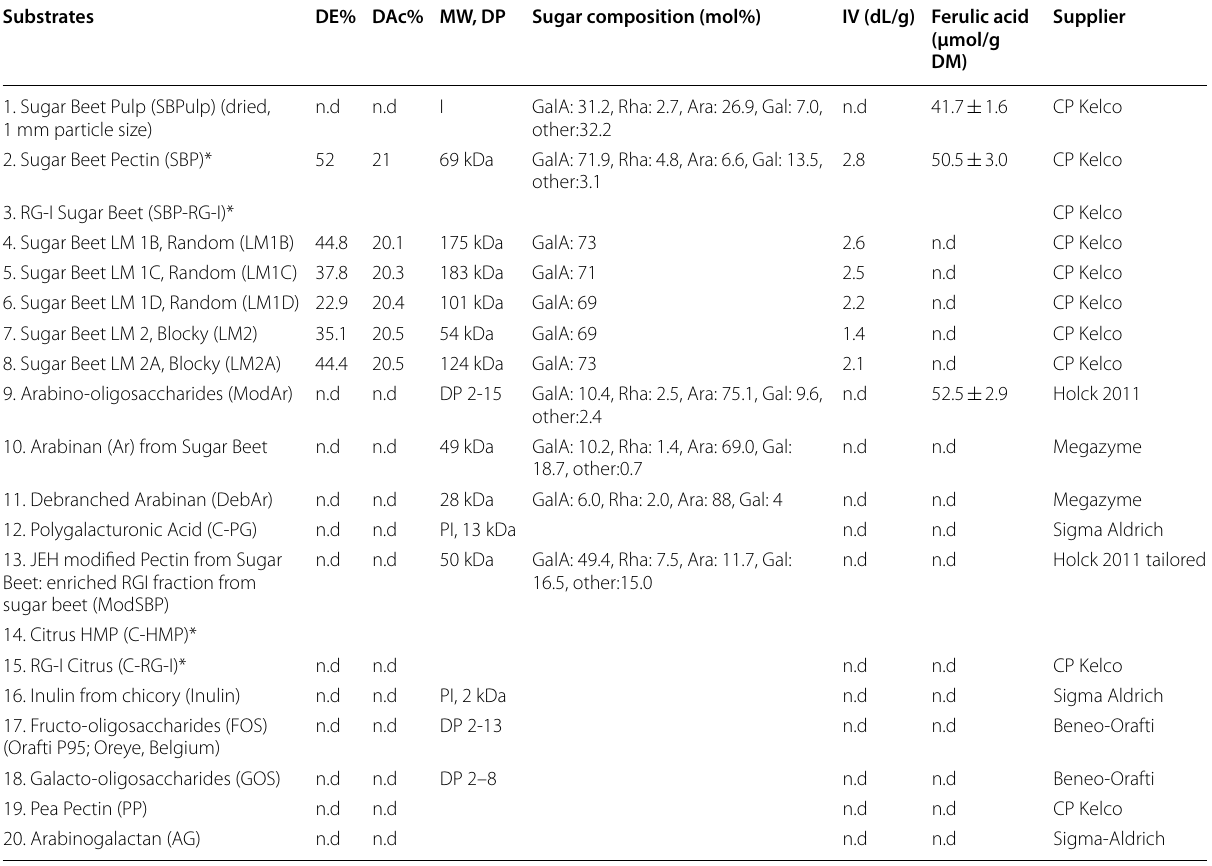
All fermentations tested with 1% (w/v) substrate except were indicated with *, where 0.5% (w/v) was also tested Molecular structure details such as degree of esterification (DE), degree of acetylation (DAc), molecular weight (MW), degree of polymerization (DP), intrinsic viscosity (IV) and the sugar composition is also listed (abbreviations: n.d. not determined, LM low methylated, HMP high methylated citrus pectin, RG rhamnogalacturonan, GalA galacturonic acid, Rha rhamnose, Ara arabinose, Gal galactose, S soluble, IN insoluble, PI partly insoluble)